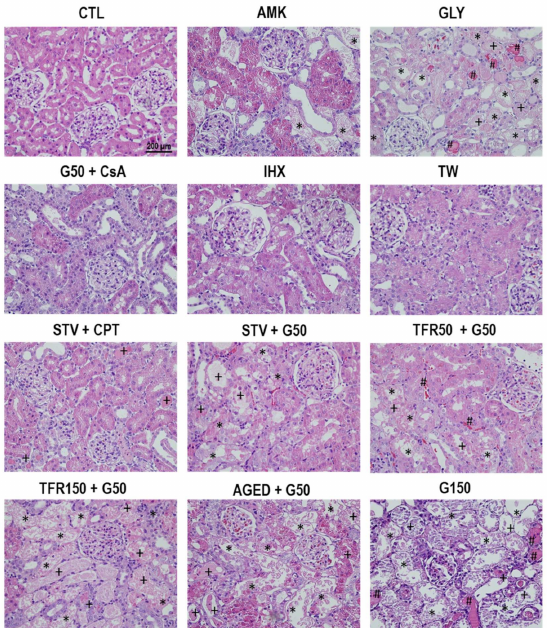
Figure 1. Cortical histology. Representative images of the renal cortex of rats from the AKI models included in the study. (+ luminal debris, * tubular necrosis, # tubular obstruction).